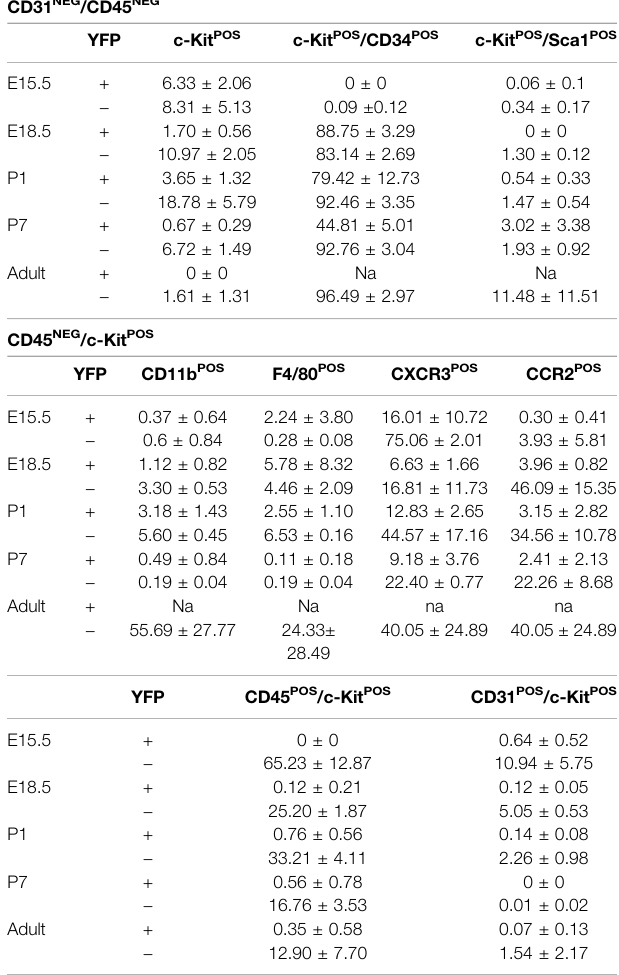
TABLE 1 | Percentage of c-Kit POS cells included in both YFP POS and YFP NEG fractions into the different characterized subpopulations (mean ± s.e.m.). CD31 NEG /CD45